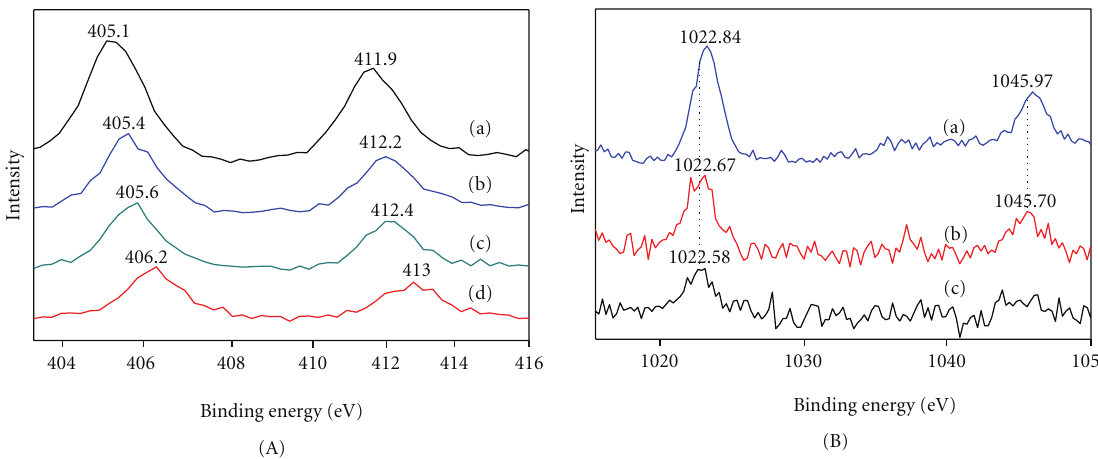
Figure 3: XPS spectra of Cd 3d 5 / 2 and 3d 3 / 2 of Cd 1 − x Zn x S / SiO 2 with di ff erent composition (A): (a) x = 0, (b) x = 0.2, (c) x = 0.4, and (d) x = 0 . 6 and XPS spectra of Zn 2p 3 / 2 and 2p 1 / 2 of Cd 1 − x Zn x S / SiO 2 series (B): (a) x = 1, (b) x = 0.8, and (c) x = 0.6.